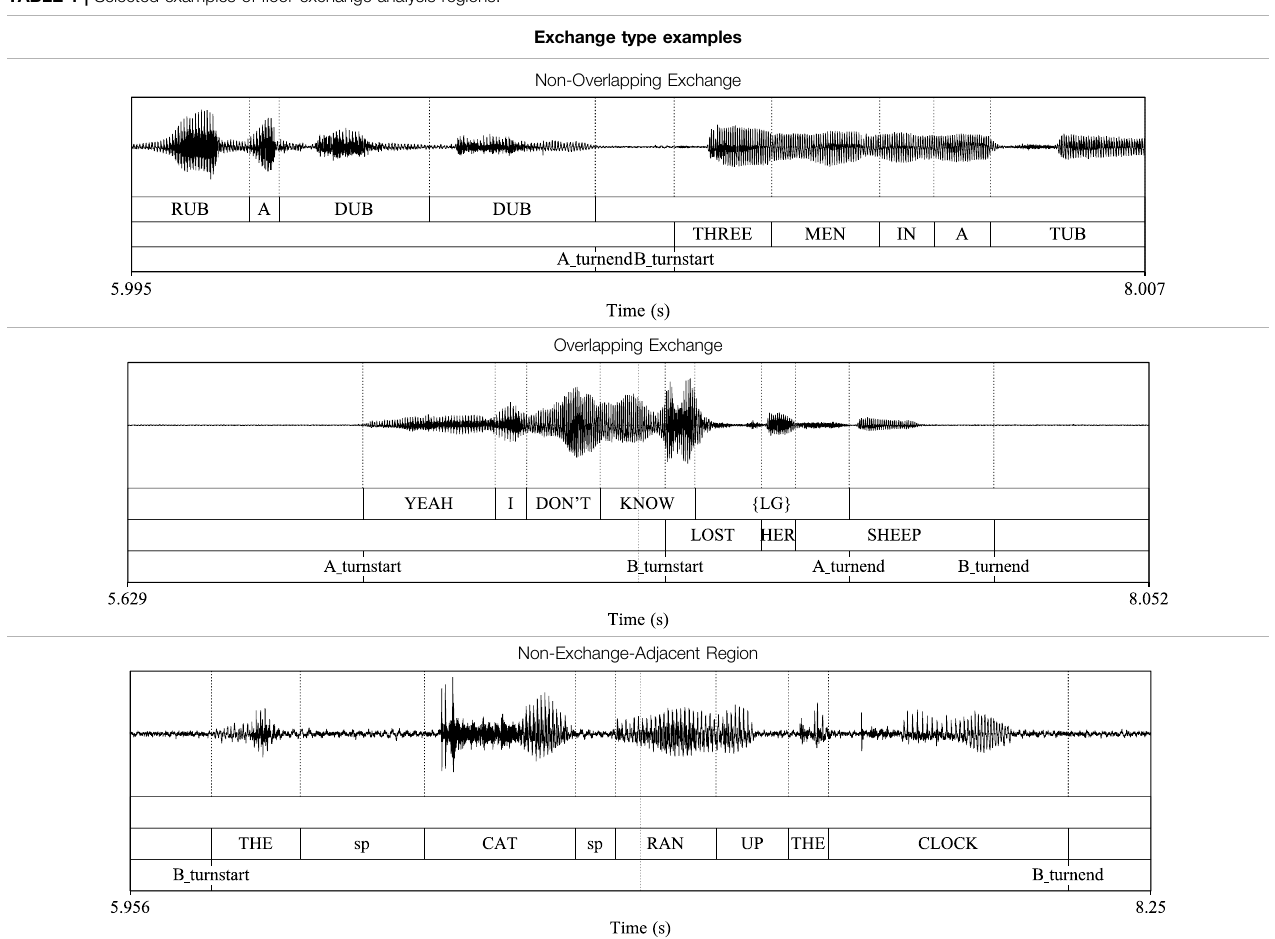
TABLE 1 | Selected examples of fl oor exchange analysis